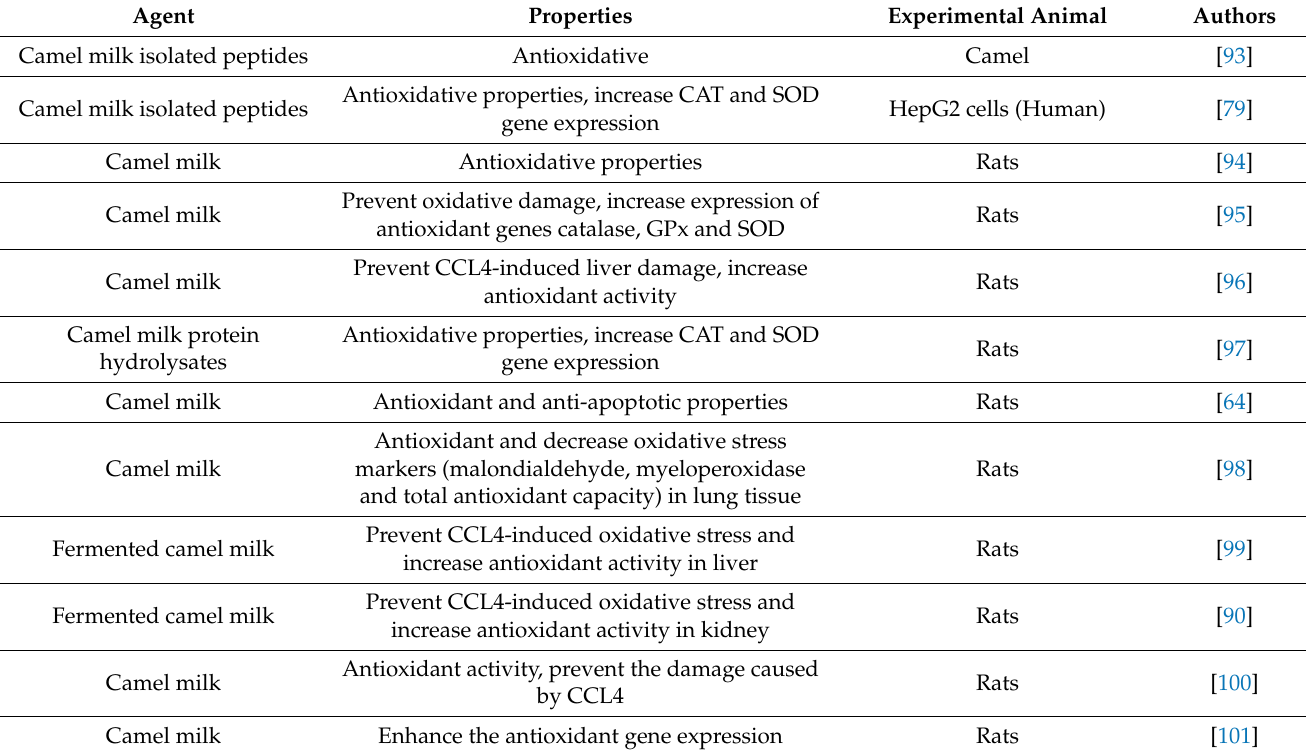
Table 1. Antioxidant properties of camel